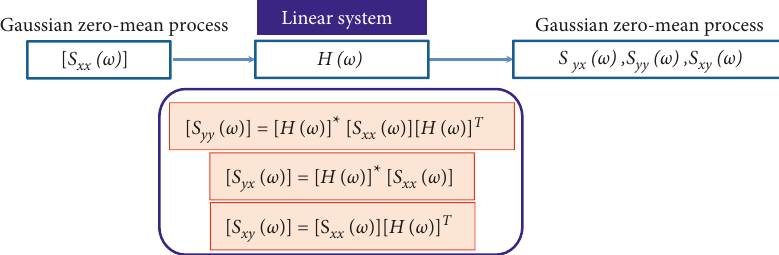
Figure 5: Principle between stochastic excitation and systematic